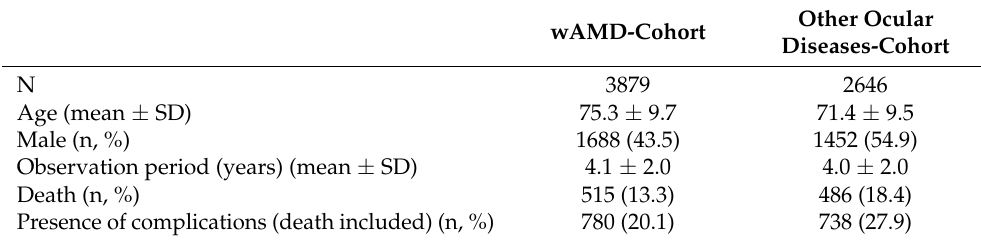
Table 1. Demographic and clinical characteristics of wAMD patients and those affected by other ocular